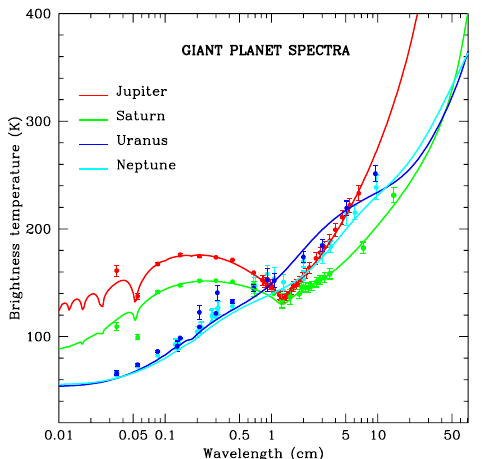
Figure 2. Spectra of the four giant planets, as indicated. The solid lines present good matches to the data; the points are data from the VLA, the Planck telescope, and ALMA (see Figures 4, 11, 15, and 18 for